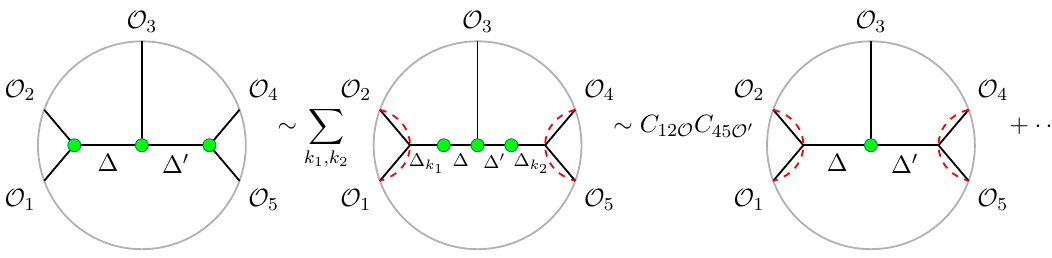
Figure 3 . Attempting a conformal block decomposition of a (cid:12)ve-point bulk diagram. Just for this (cid:12)gure, we have used the shorthand: (cid:1) k in the third step shows the unevaluated R ^ K ^ G ^ G AdS